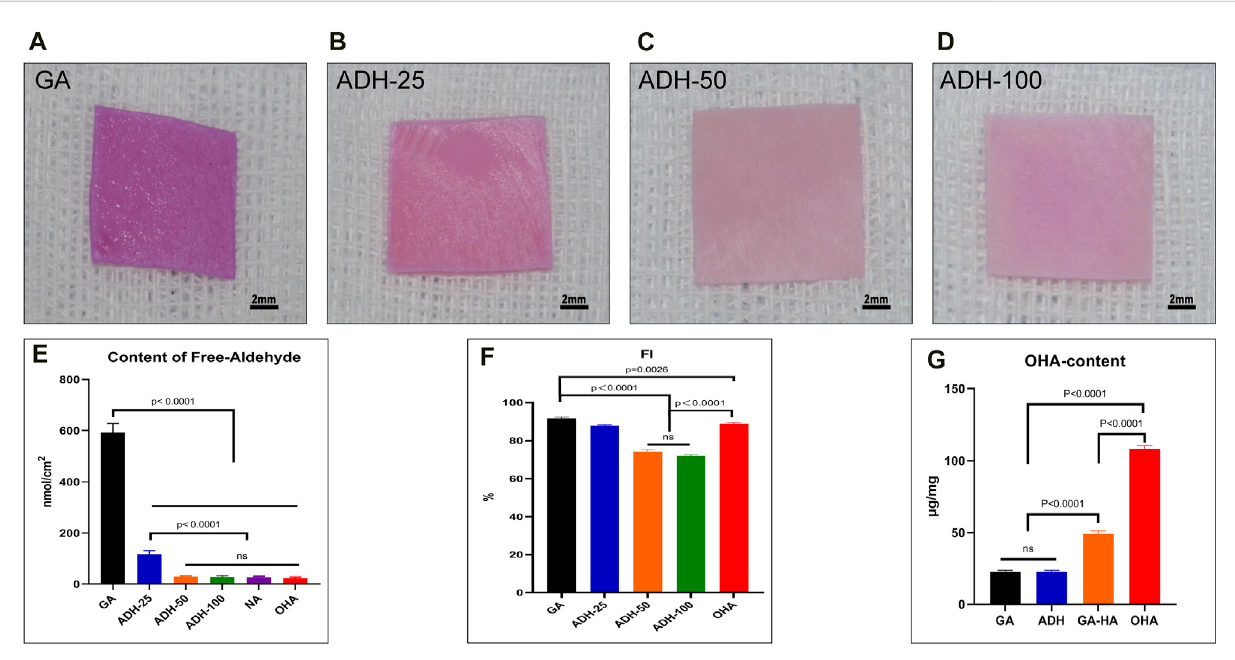
FIGURE 2 Qualitative and quantitative analysis of free aldehyde groups in pericardial tissues. The images show the staining results of Schiff base reagents, and purple-red represents the residual aldehyde groups (A – D) . The results of quantitative analysis showed that the residual aldehyde groups in the GA group were signi fi cantly higher than those in the ADH and OHA groups (E) . Quantitative analysis of free amino groups in tissues (F) . Qualitative analysis of OHA content in tissues (G)